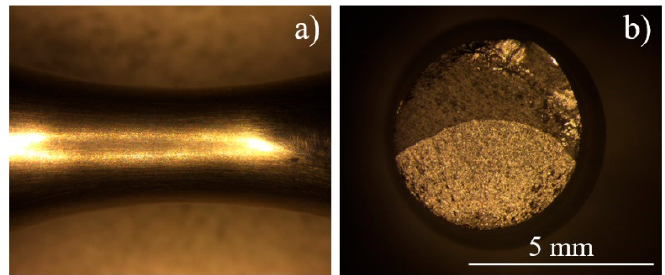
Figure 12. OM fracture images of aged Inconel 718 ( R = − 1, f = 20 kHz, σ a = 540 MPa, Nf = 1.57 × 10 9 cycles): ( a , b ) specimen surface.